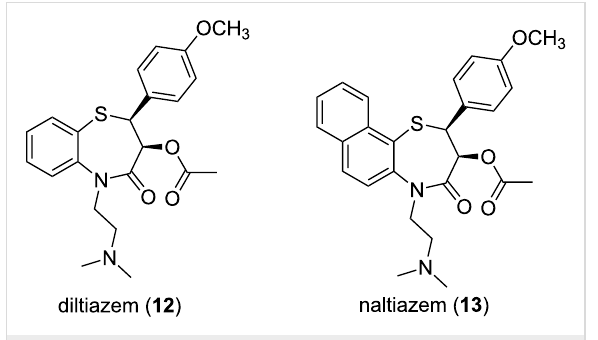
Figure 3: Some synthetic β -hydroxy sulfides of clinical